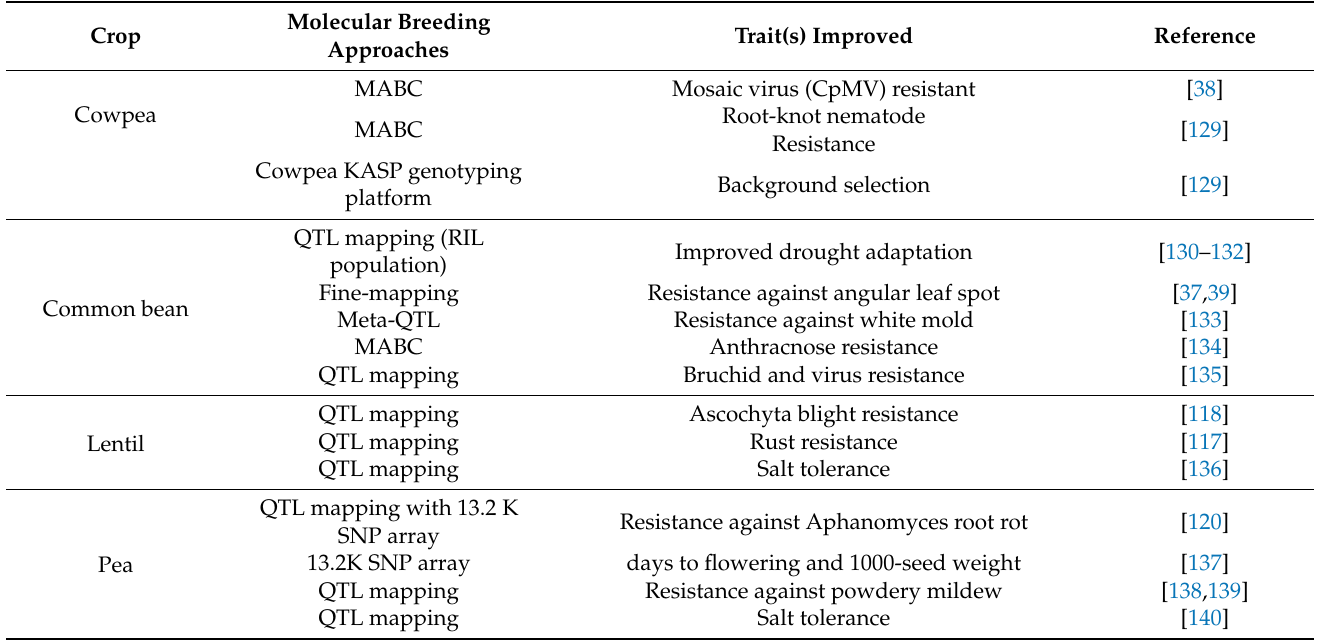
Table 2. Genomic resources and genotyping platforms for the improvement of legume